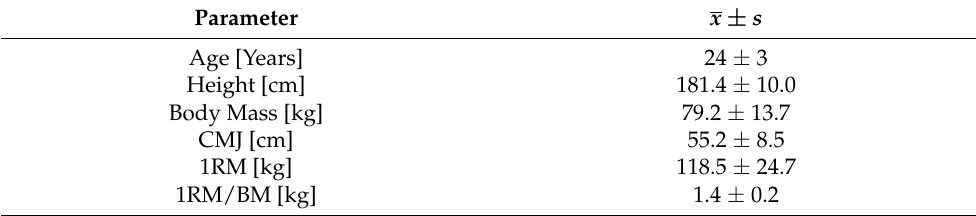
Table 1. Subjects